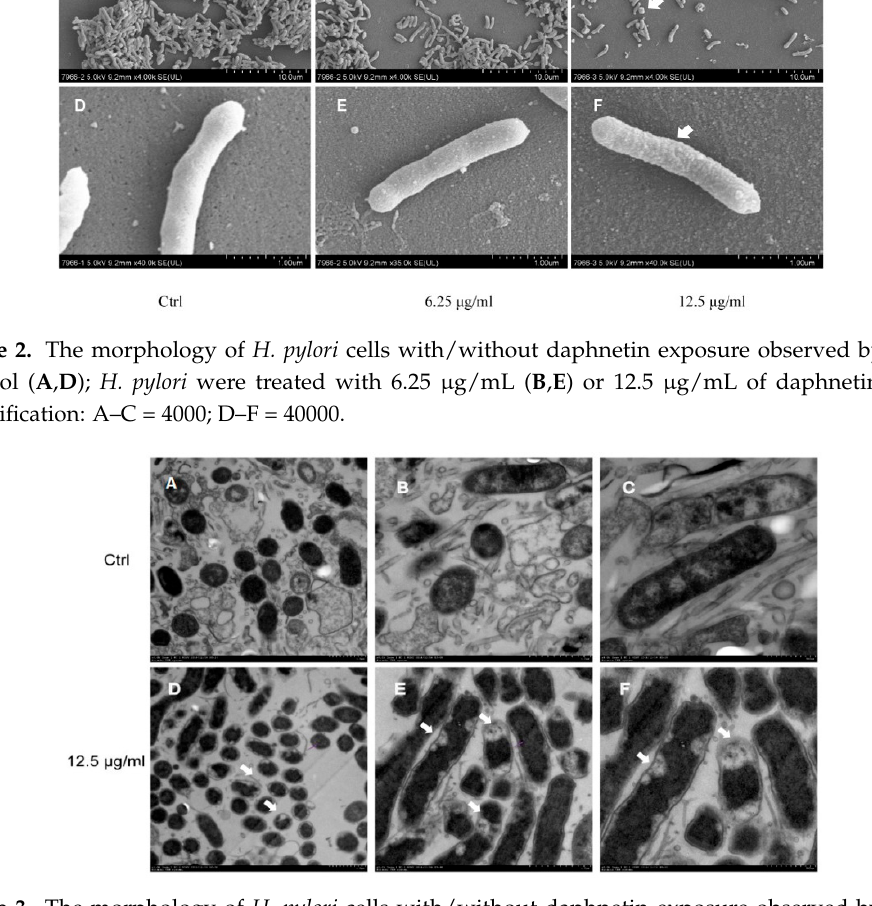
Figure 3. The morphology of H. pylori cells with/without daphnetin exposure observed by TEM. Control ( A – C ); H. pylori treated with 12.5 μ g/mL daphnetin ( D – F ). Magnification: A and D = 3000; B and E = 5000; and C and F = 8000.